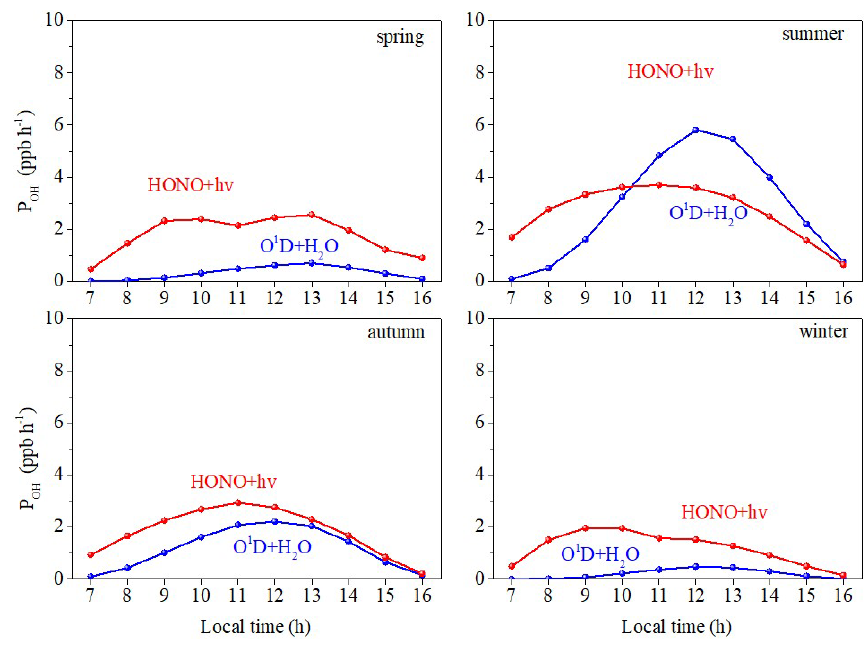
Figure 12. Comparison of OH formation by photolysis of HONO and O 3 in the four